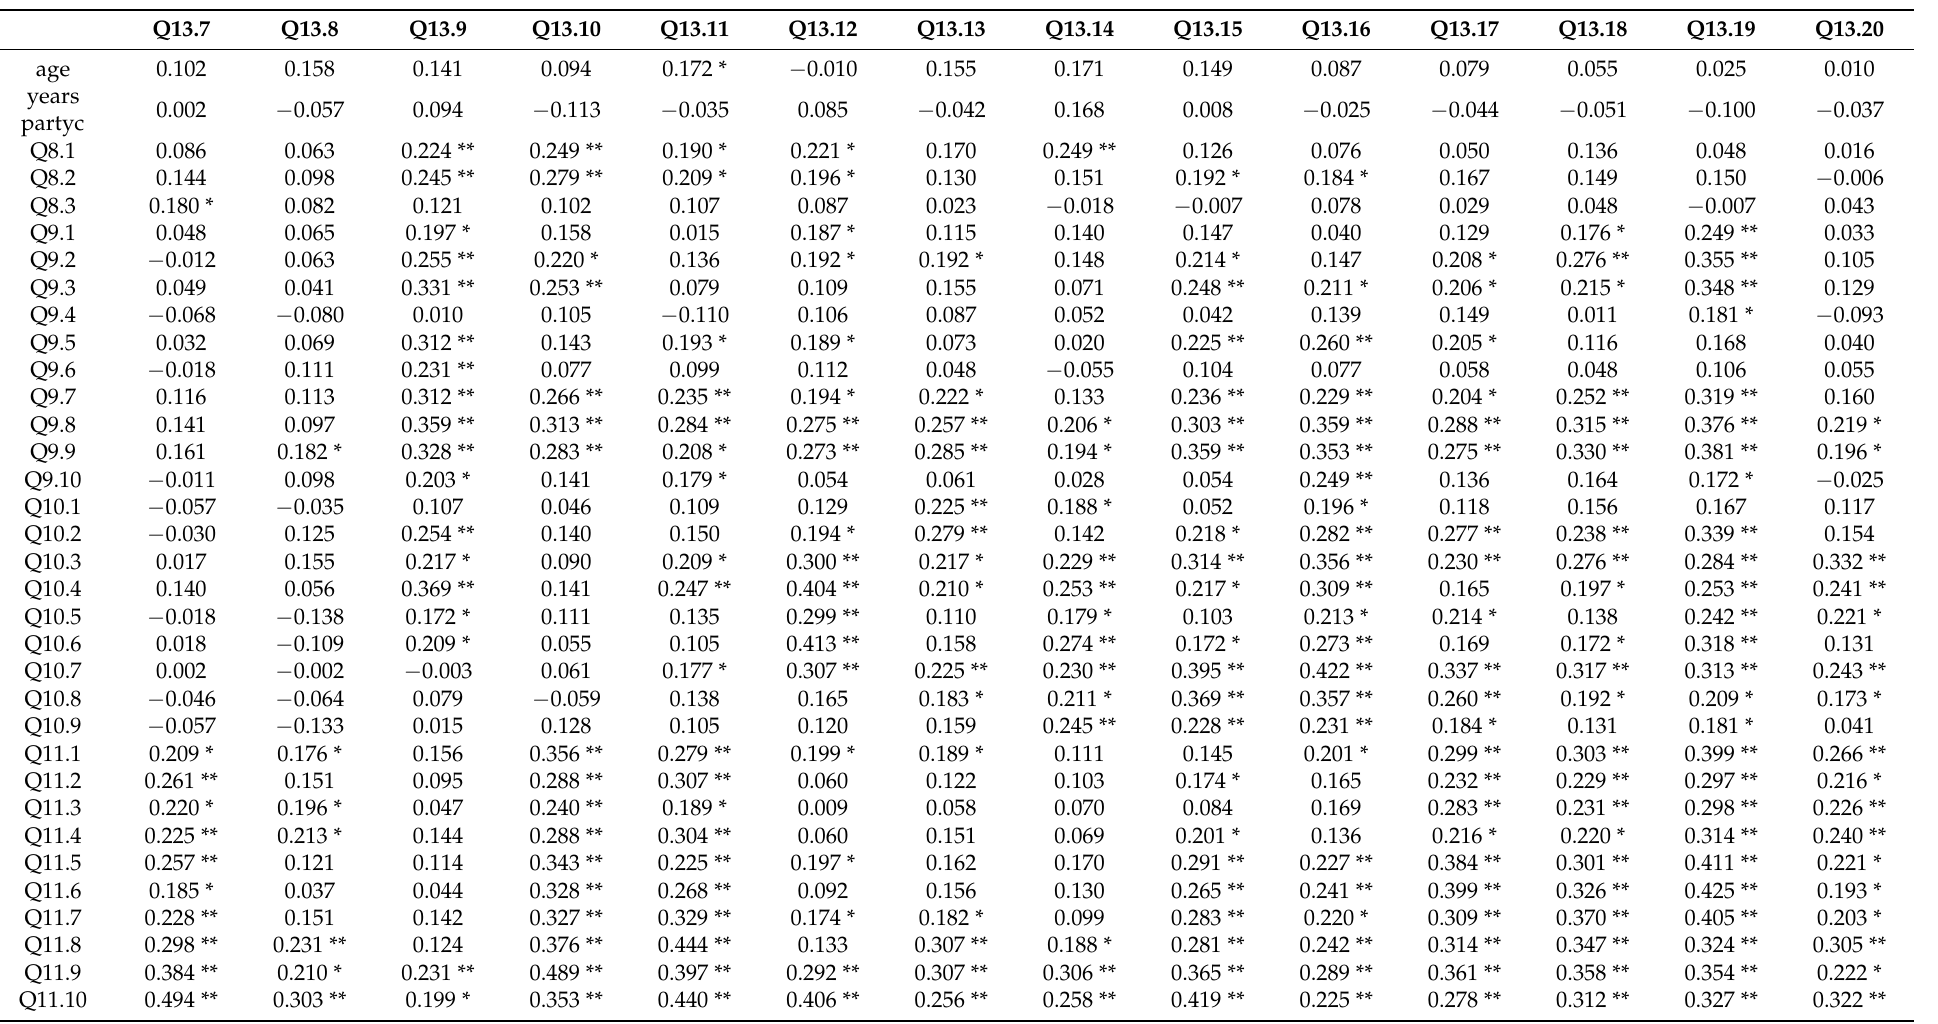
Table A4. Pearson’s correlation matrix, * significant at the alpha 0.05 level, ** significant at the alpha 0.01